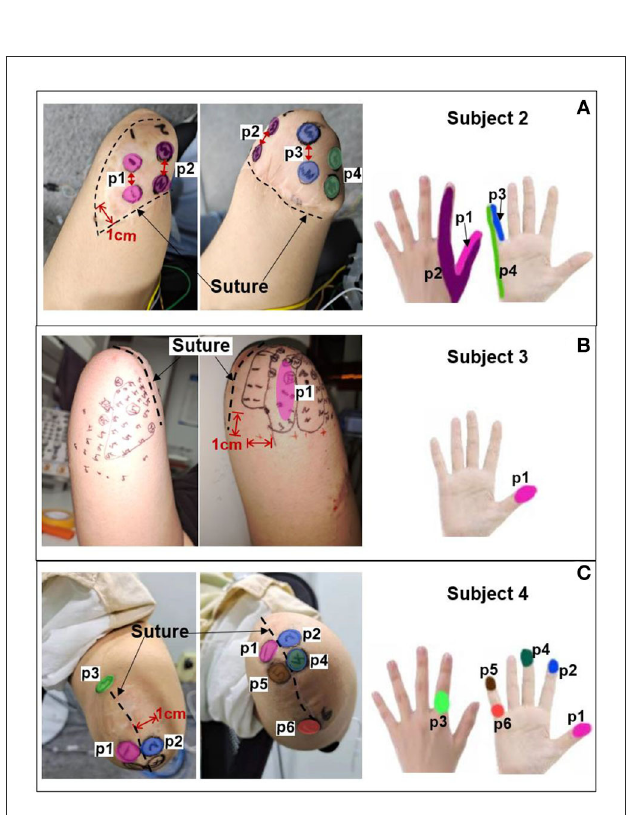
FIGURE5 PHMs, determined stimulus positions, and corresponding sensation positions for additional three amputees. (A) Subject 2. (B) Subject 3. (C) Subject